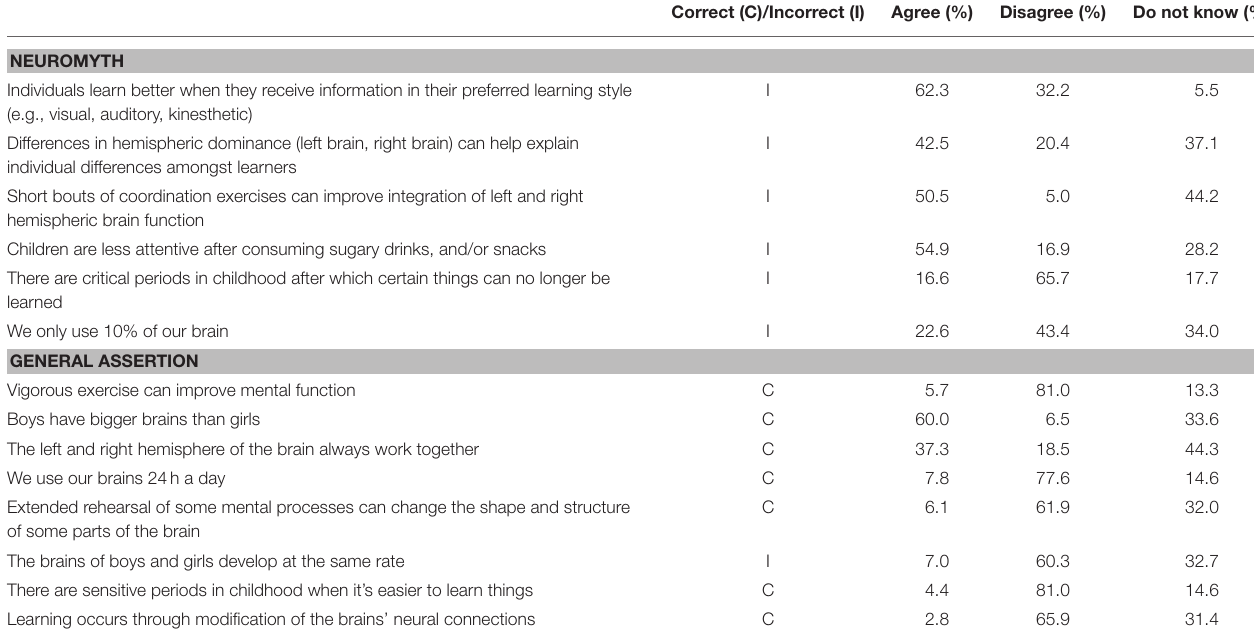
Correct (C)/Incorrect (I) Agree (%) Disagree (%) Do not know (%)